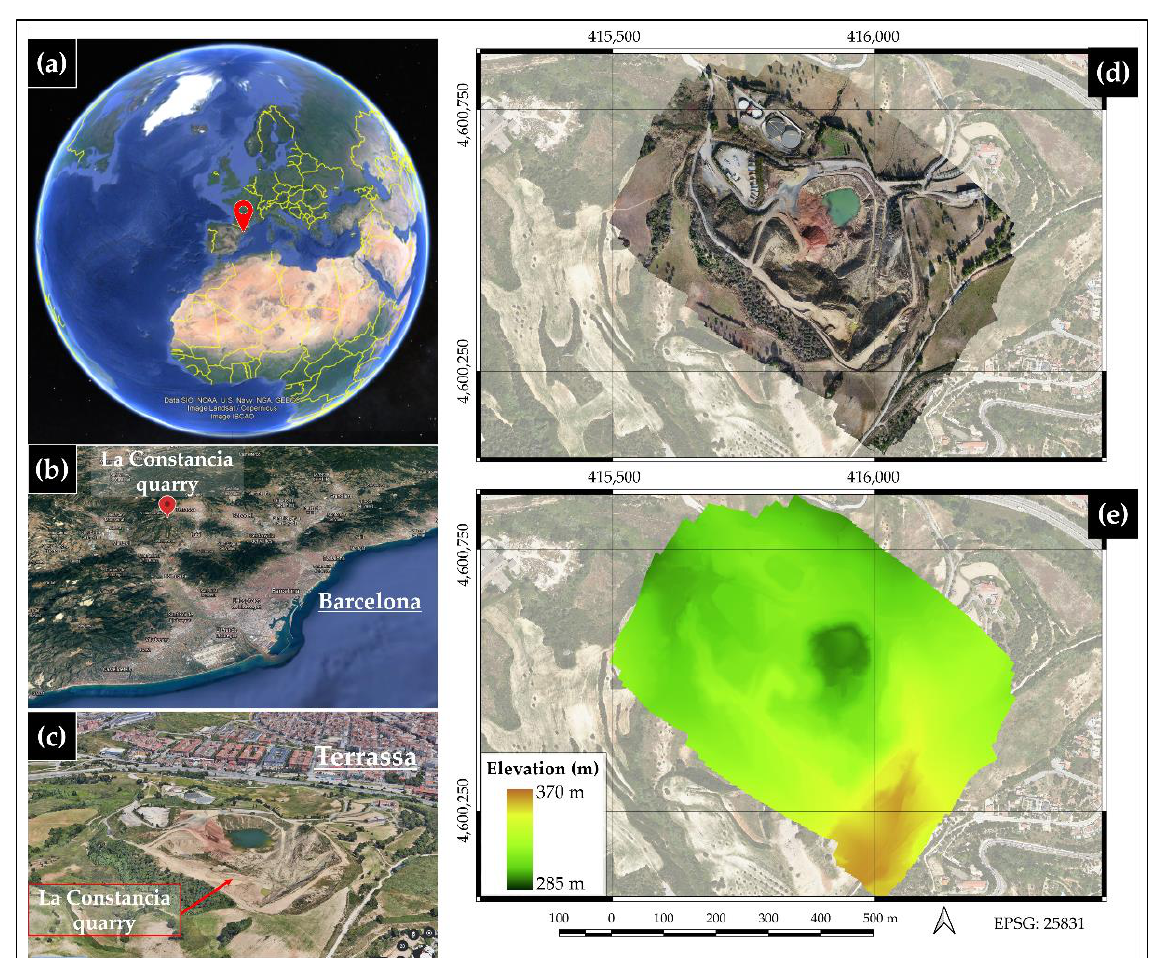
Figure 1. ( a ) Location of the study area. Source: Modified from Google Earth. ( b ) Regional location of “La Constancia” quarry near Barcelona, Spain, Europe. Source: Modified from Google Earth. ( c ) Local location of “La Constancia” quarry in Terrassa, Catalonia. Source: Modified from Google Earth. ( d ) Orthoimagery of the “La Constancia” quarry. Source: Drone imagery acquired during this study processed by the authors. ( e ) Digital Elevation Model of the “La Constancia” quarry. Source: Drone imagery acquired during this study was processed by the authors.